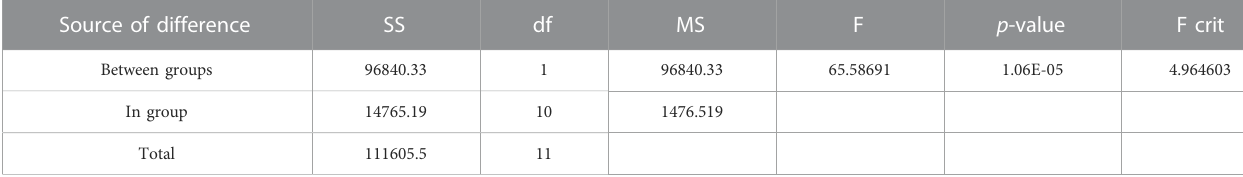
TABLE 16 Variance analysis of ultrasonic frequency effect on point C. Source of